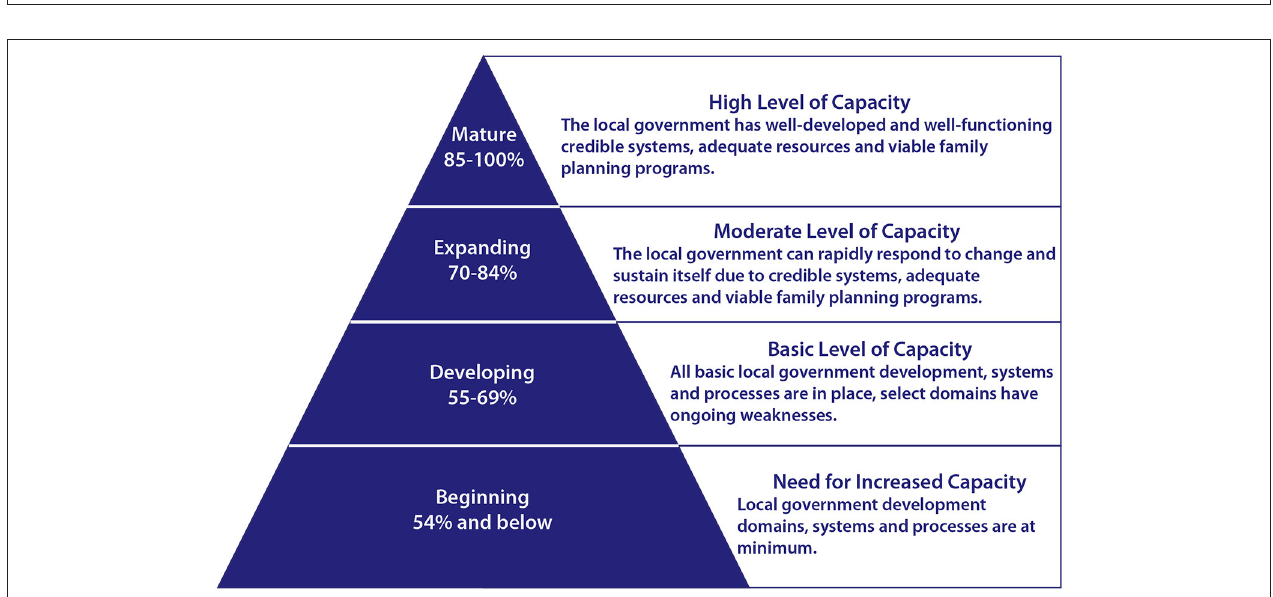
FIGURE 3 | Four levels of performance are possible when conducting a RAISE